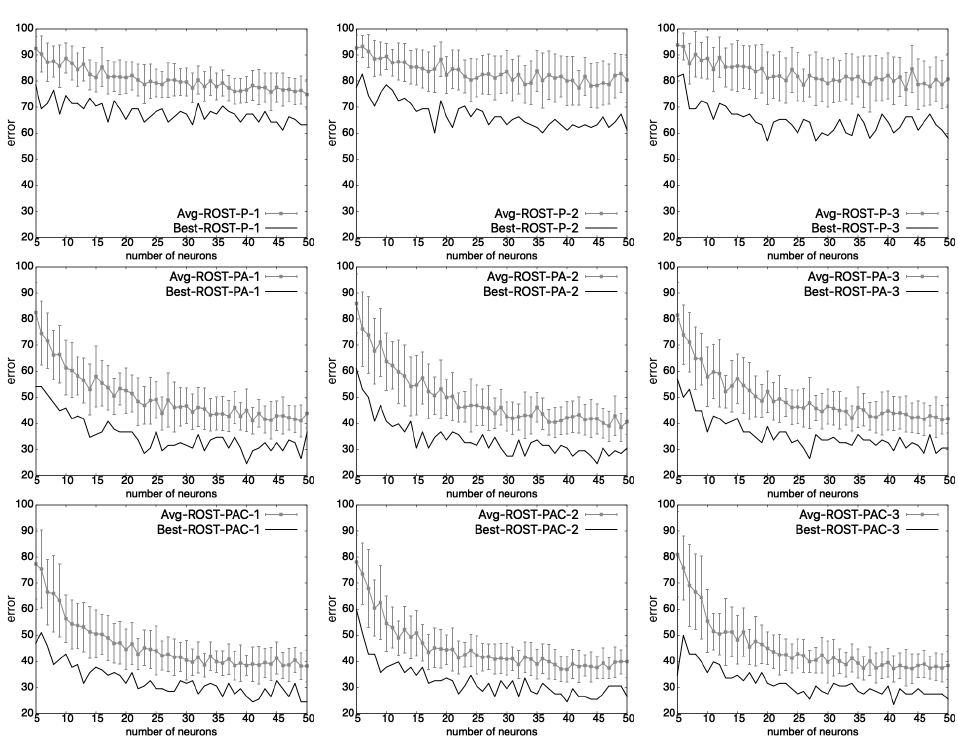
Figure A3. ANN results on the considered datasets. On each set, 30 runs are performed by ANNs with the hidden layer containing from 5 to 50 neurons. The percentage of incorrectly classified data is plotted. Best stands for the best solution (out of 30 runs), Avg stands for Average (over 30 runs), and the Standard Deviation is represented by error